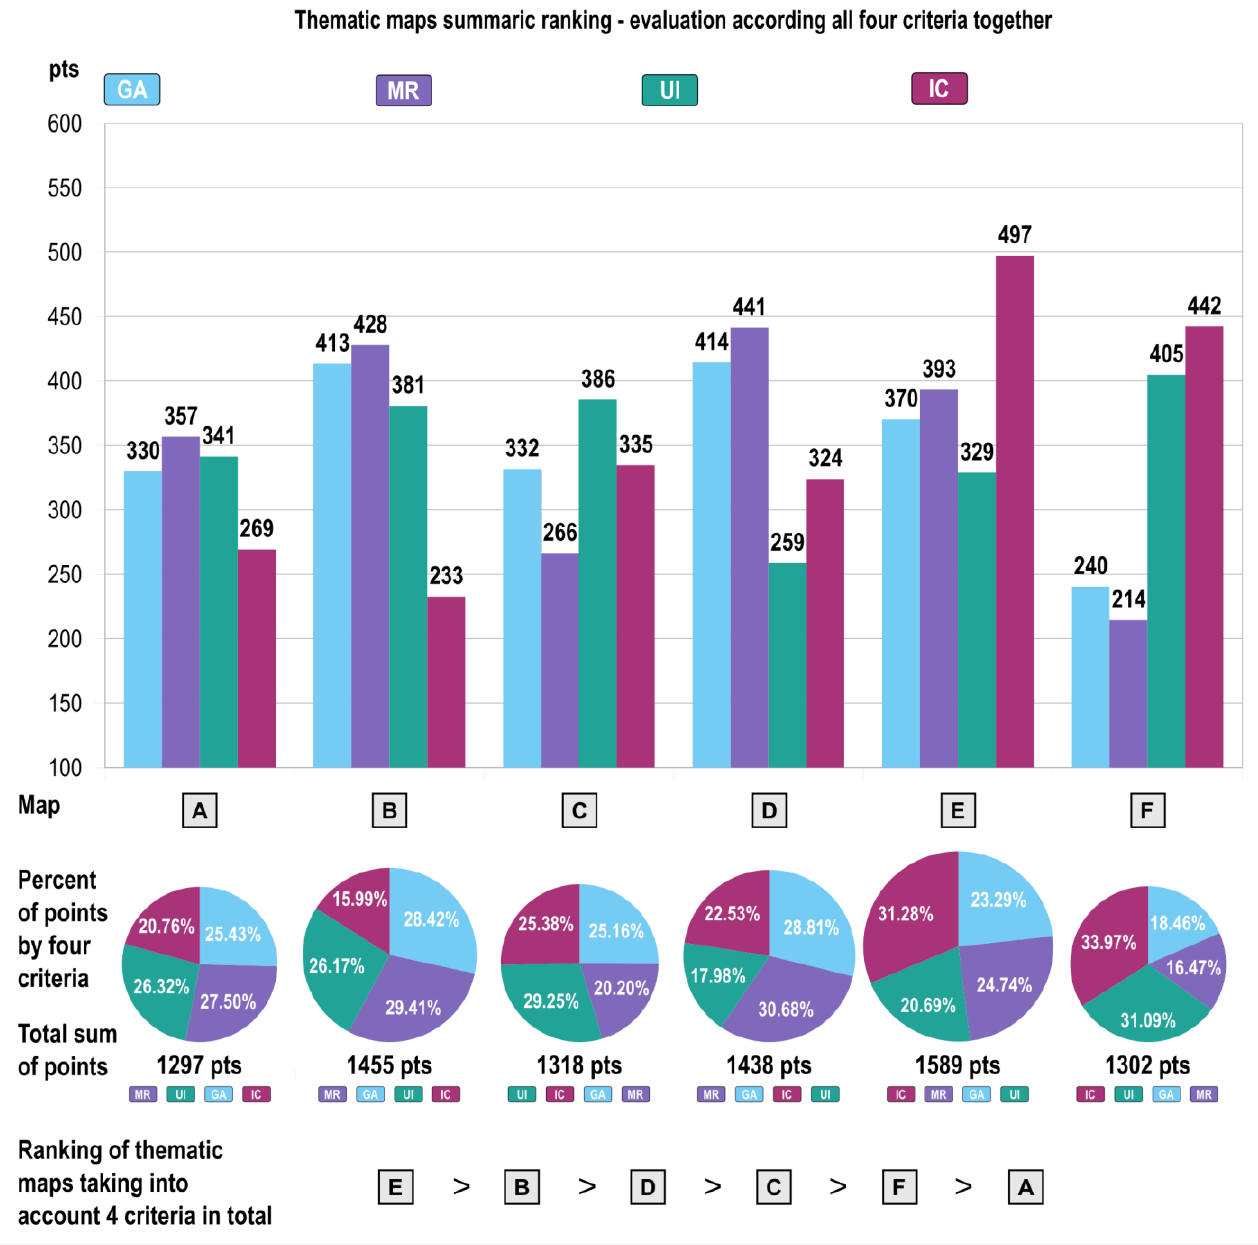
Figure 5. Thematic maps ranking according to four subjective evaluation criteria in comparative and summary terms — total number of points and the percentage share of individual criteria in the overall result.